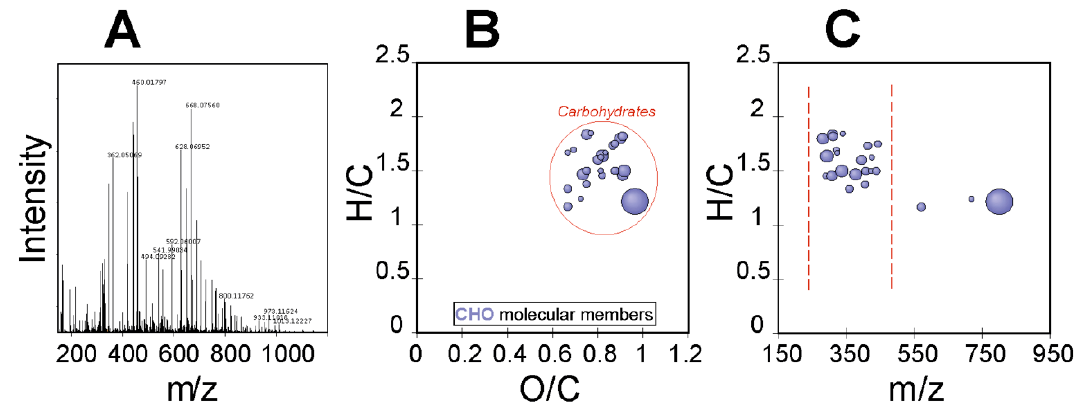
Figure 4. Detected carbohydrates in the R. tataouinensis EPS sample as detected by FT-ICR-MS: ( A ) Full mass spectrum, ( B ) van Krevelen diagram, and ( C ) mass-edited H/C ratios plot.